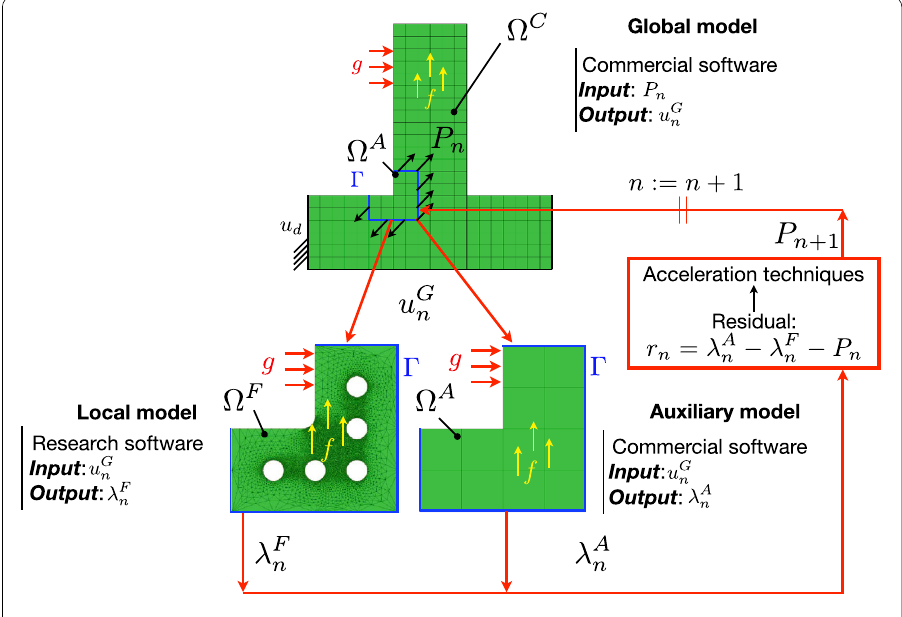
Fig. 2 Flow chart of global/local